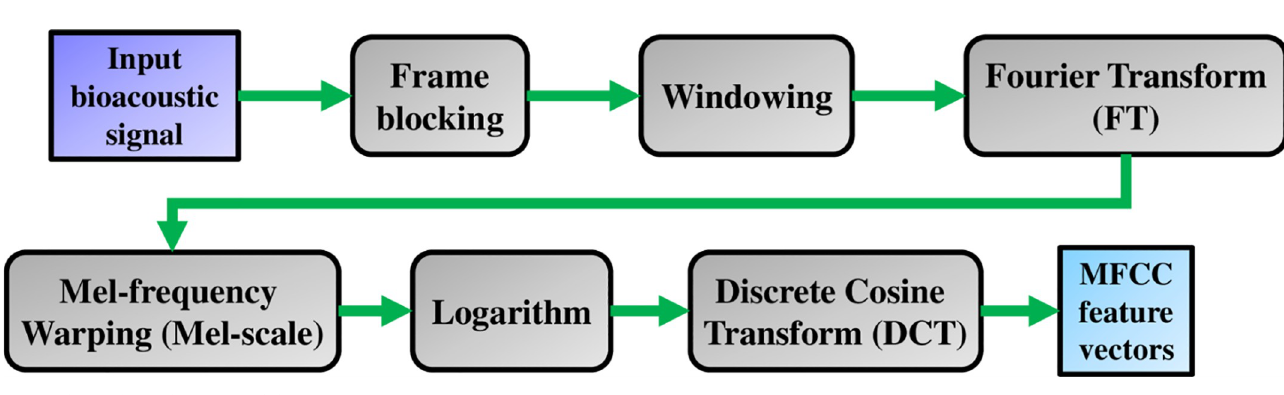
Fig 3. Shows the architecture of the